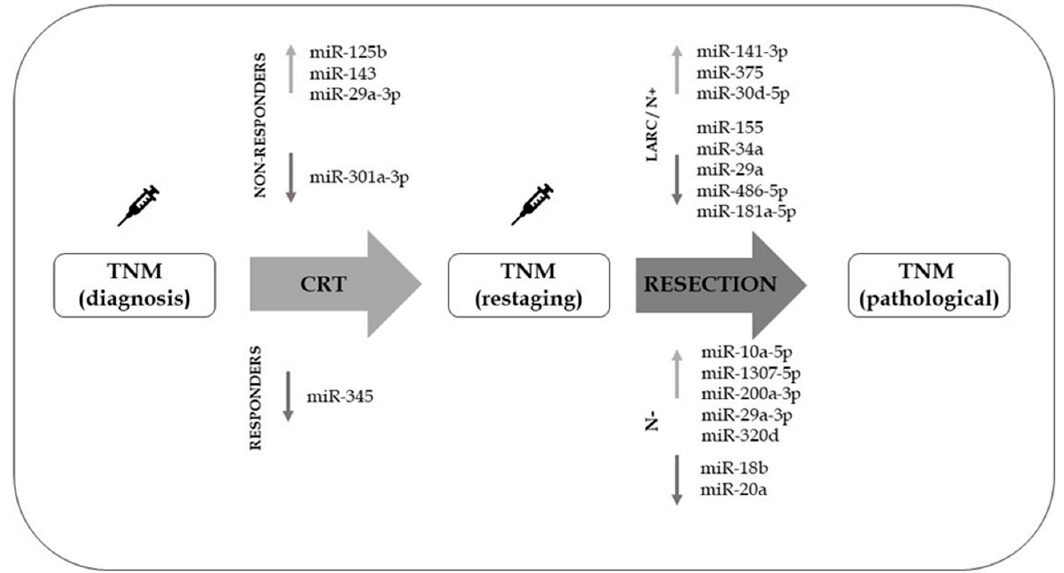
Figure 1. Circulating microRNAs involved in response to chemoradiotherapy or reflecting TNM staging of rectal